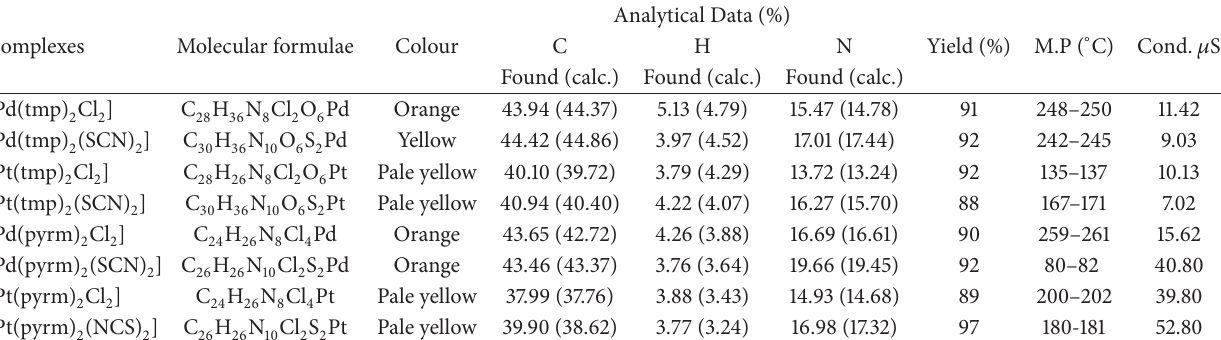
Table 1: Analytical data and some physical properties of the metal complexes.